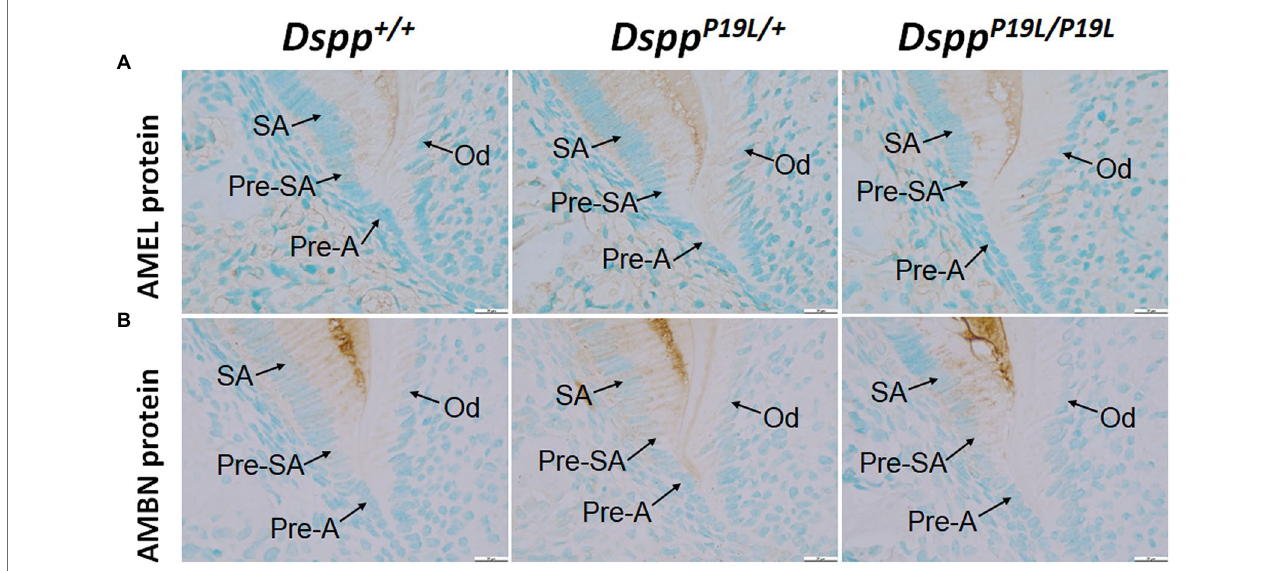
FIGURE 7 | Immunohistochemical staining of amelogenin (AMEL) and ameloblastin (AMBN). All images are the sagittal section and distal cervical region of the mandibular first molars of 1-week-old wild-type Dspp +/+ , heterozygous Dspp P19L/+ and homozygous Dspp P19L/P19L mice. (A) Immunohistochemical staining of AMEL (signal in brown). (B) Immunohistochemical staining of AMBN (signal in brown). All three groups of mice showed a similar distribution and intensity of AMEL and AMBN immunostaining signals in the enamel matrices. SA, secretory ameloblasts; Pre-SA, presecretory ameloblast, Pre-A, preameloblasts; and OD, odontoblasts. Scale bars: 20 μ m in